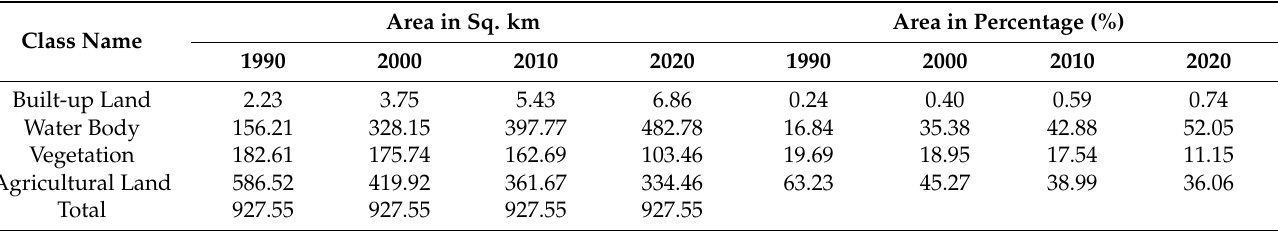
Table 3. LU/LC area change examination.